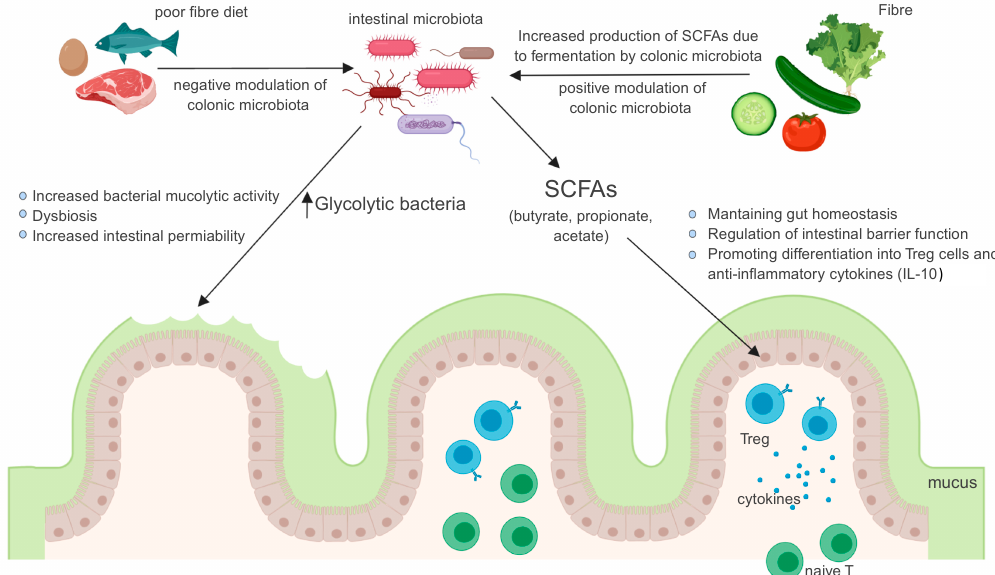
Figure 1. Interaction of dietary fiber with the gut microbiota.